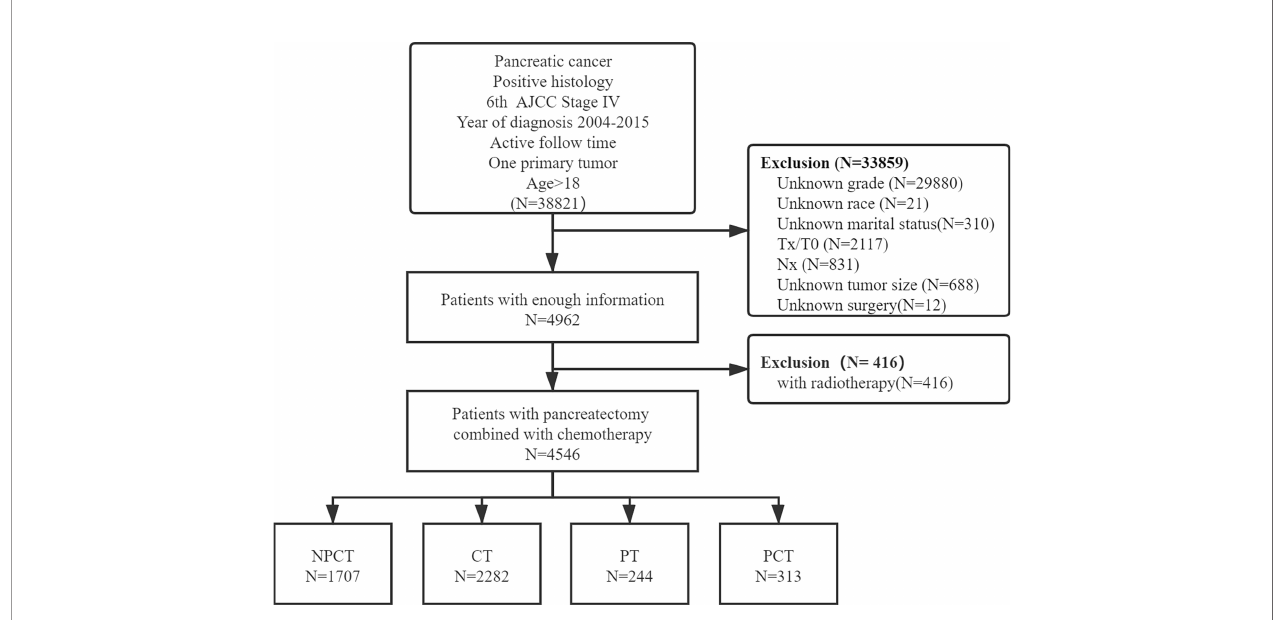
FIGURE 1 | Flowchart of patient selection for this